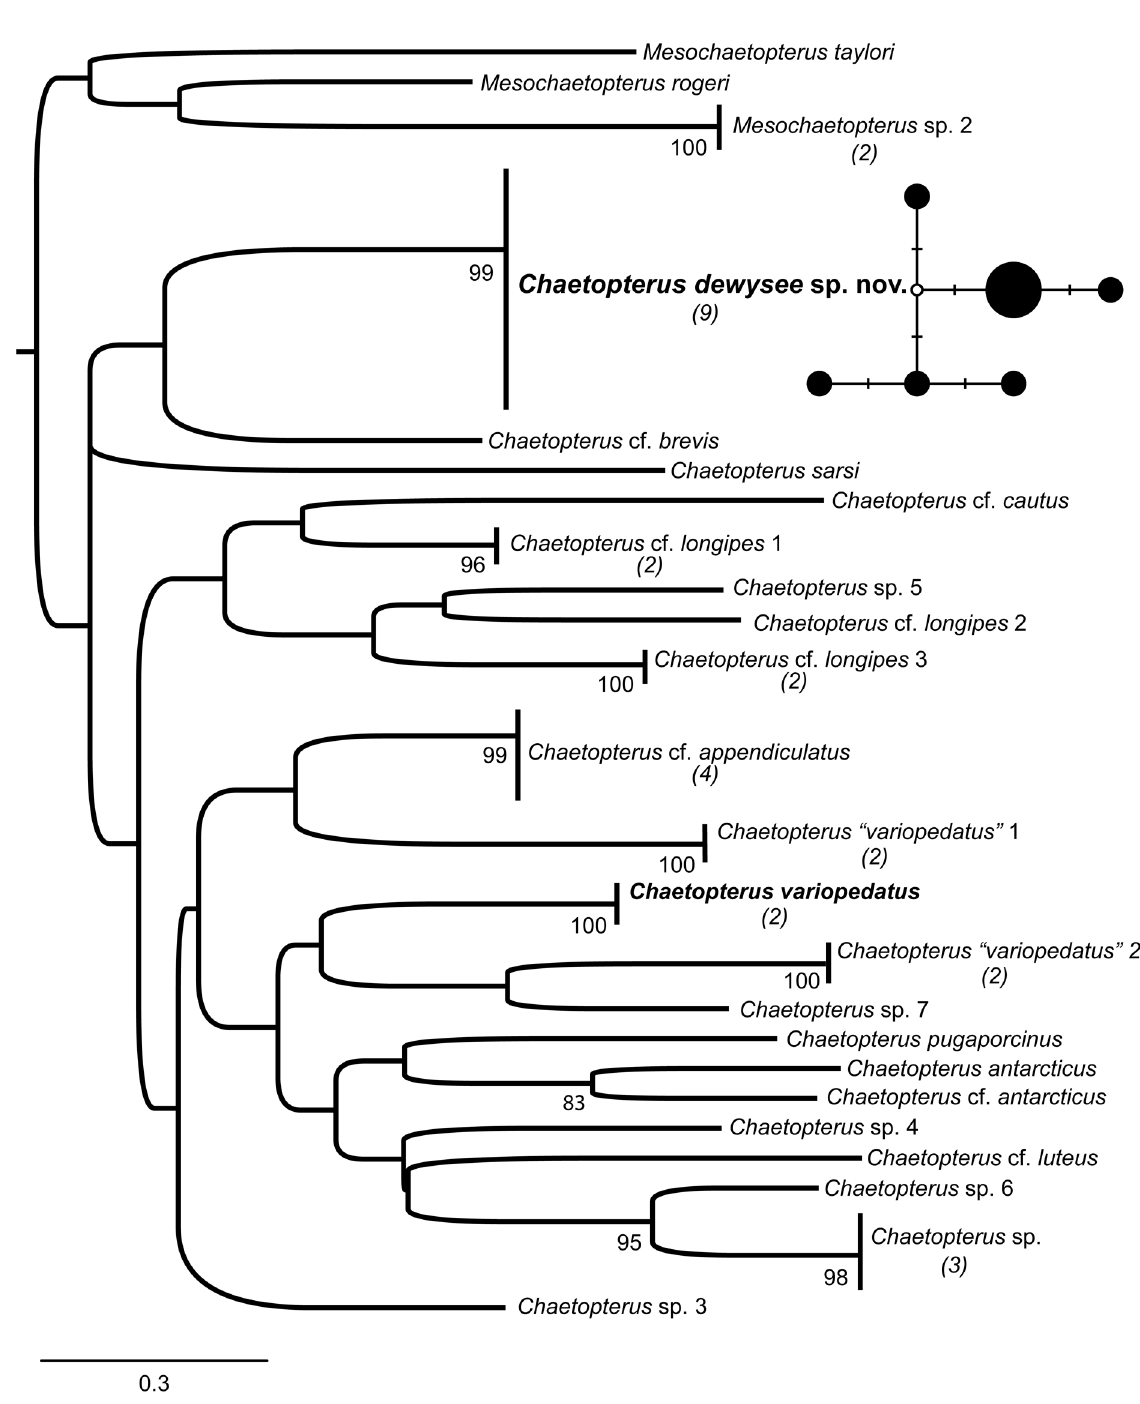
Fig. 5. Maximum likelihood tree of Chaetopterus Cuvier, 1830 spp . COI sequences with the Mesochaetopterus Potts, 1914 clade as outgroup, based on Moore et al. (2017). Only bootstrap supports > 80 are shown. The new species Chaetopterus dewysee sp. nov. and C. variopedatus (Renier, 1804) from the type locality are in bold. Number of sequences included for each terminal is in brackets. Details on sequences that were analyzed can be found in Table 1. Haplotype network for the nine Chaetopterus dewysee sp. nov. sequences is shown next to the